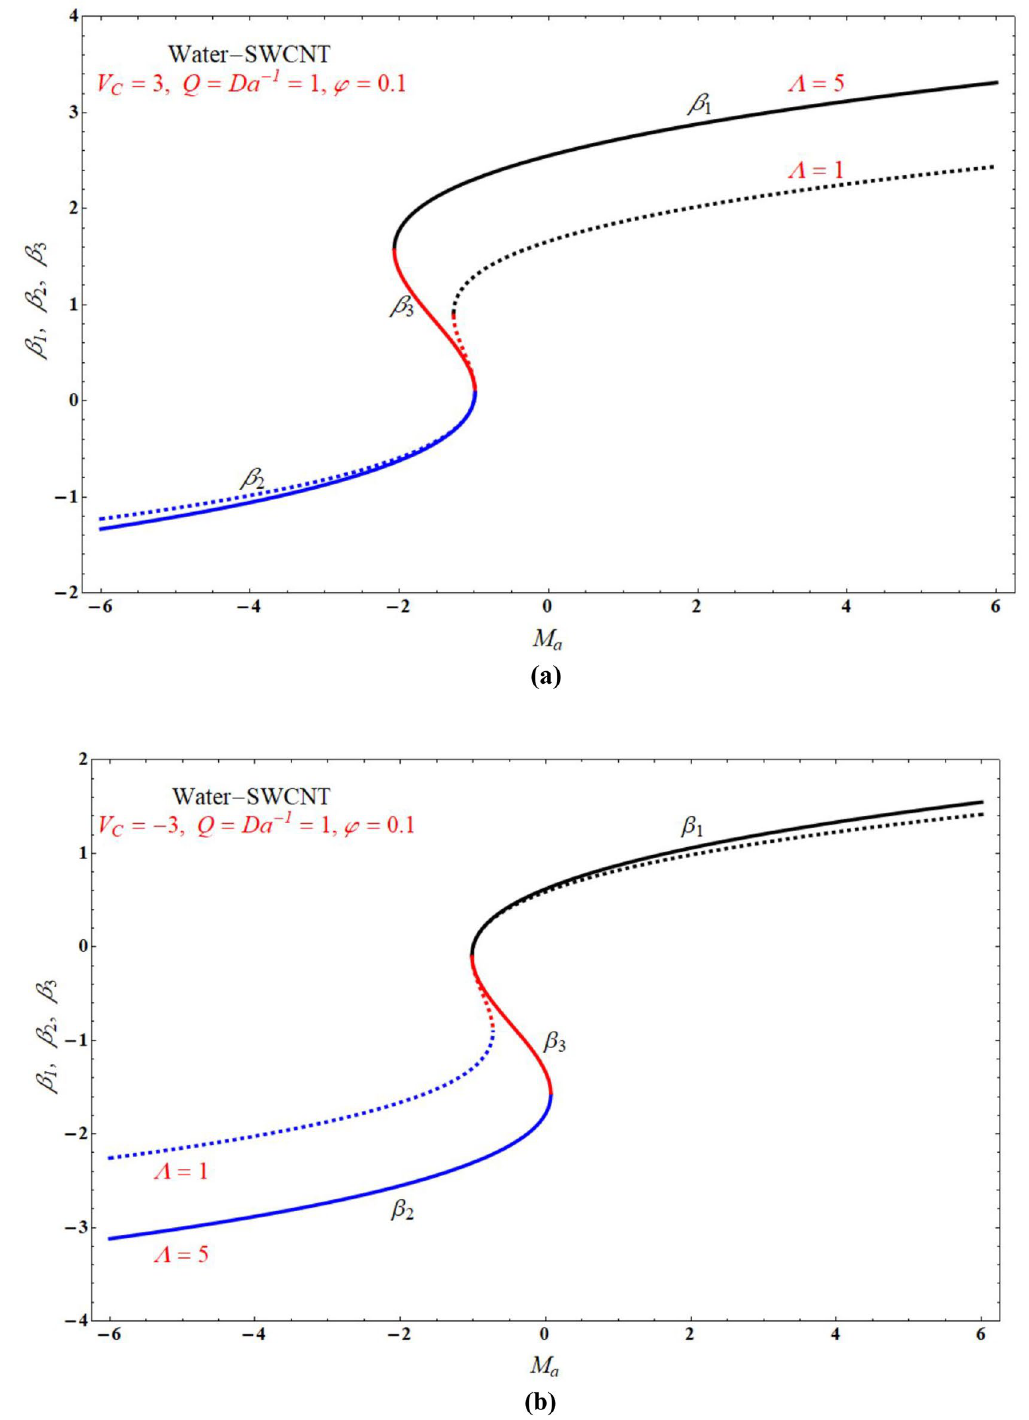
Figure 3. The plots of β 1 , β 2 , β 3 verses Ma for (cid:31) = 5 and (cid:31) = 1 cases at ( a ) V C = 3 , and ( b ) V C = − 3